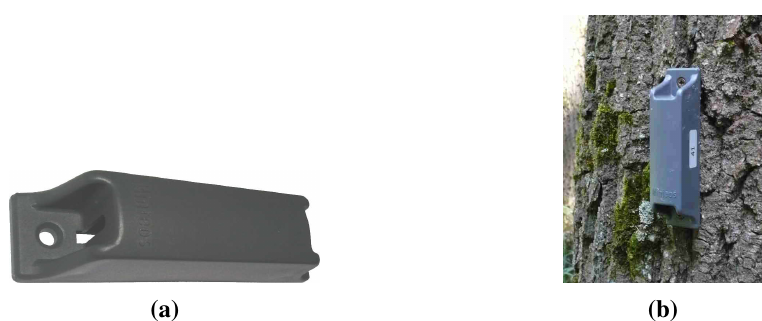
Figure 8. Sensor node package hosting the PCB, a half-AA battery and the normal mode helix antenna (NMHA) antenna. The aperture on the left improves the NTC thermal contact ( a ); fixed on trees with screws ( b